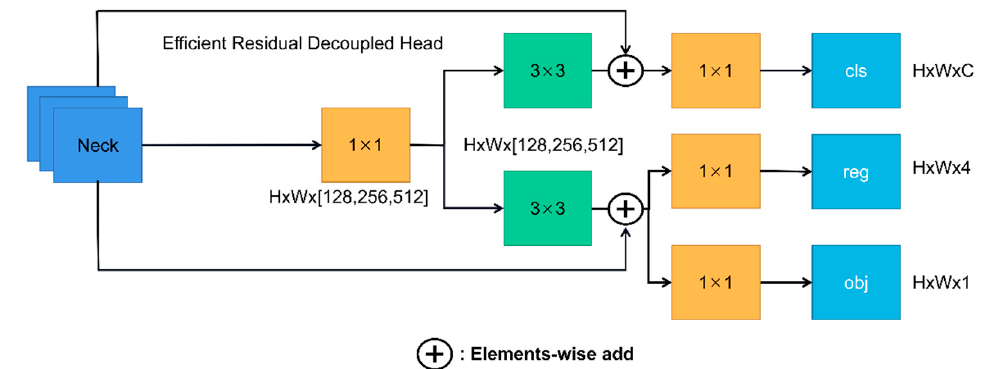
Figure 6. An illustration of the structure of ERDHead. In the figure, we add the features in the encoder in the form of residual edges to the features used for classification and regression after the 3 × 3 convolution operation.